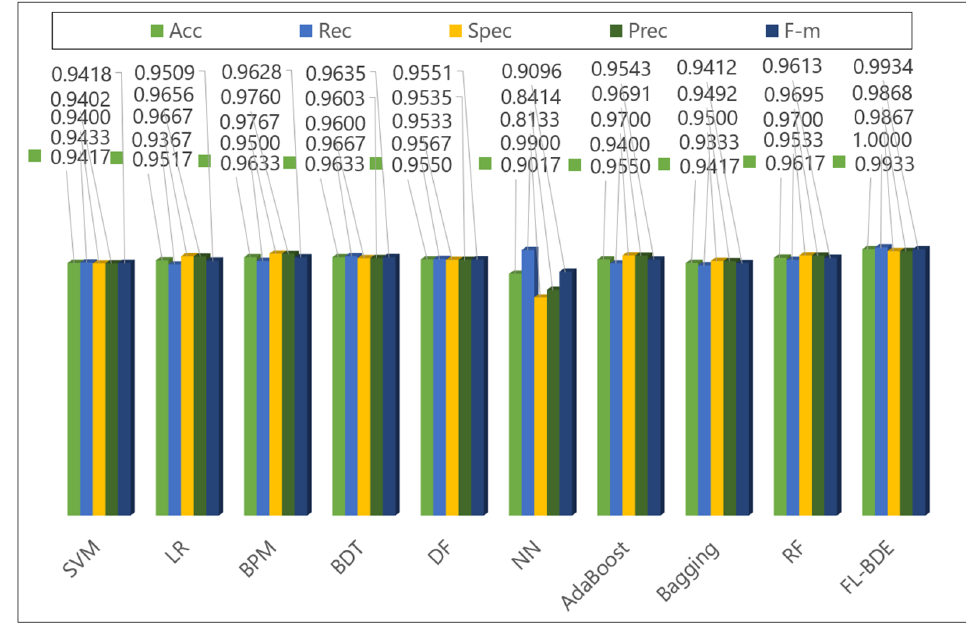
Figure 6. Performance results of FL-BDE, ML- and EL-based models at the split ratio of 0.70.